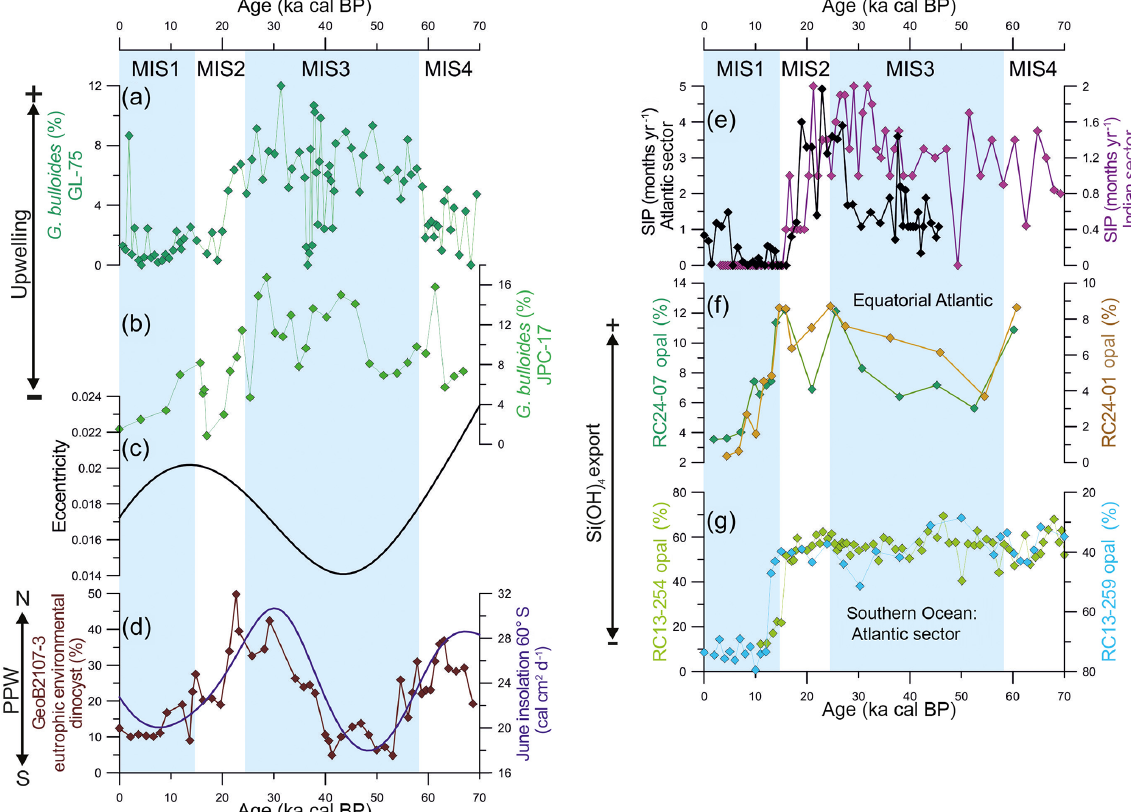
Figure 4. The mechanism behind the changes in productivity in the southern Brazilian margin over the last 70kyr. Abundance of upwelling indicator species Globigerina bulloides from (a) core GL-75 (21 ◦ S; Portilho-Ramos et al., 2015) and (b) core JPC-17 (27 ◦ S; this study). (c) Eccentricity of the Earth’s orbit (Berger and Loutre, 1991). (d) The abundance of dinoflagellate cysts from core GeoB2107-3 (27 ◦ S) representing the influence of the Plata Plume Water in the southern Brazilian margin (Gu et al., 2017) and austral winter (June) insolation at 60 ◦ S (Berger and Loutre, 1991). (e) Antarctic sea ice presence (SIP) in the Atlantic sector core TN057-13-PC4 (53 ◦ 20 (cid:48) S, 5 ◦ 10 (cid:48) W; Shemesh et al., 2002) and Indian sector core SO136-111 (56 ◦ 40 (cid:48) S, 160 ◦ 14 (cid:48) W; Crosta et al., 2004) of the Southern Ocean derived from diatoms assemblage. (f) Opal content in the equatorial Atlantic upwelling off northwestern Africa from core RC14-01 (0.55 ◦ N, 13 ◦ 65 (cid:48) W) and core RC24-07 (1 ◦ 33 (cid:48) S, 11 ◦ 92 (cid:48) W) (Bradtmiller et al., 2007) as well as (g) in the Atlantic sector of the Southern Ocean from core RC13-254 (48 ◦ 34 (cid:48) S, 5 ◦ 34 (cid:48) E) and core RC13-259 (53 ◦ 53 (cid:48) S, 4 ◦ 56 (cid:48) W) (Mortlock et al., 1991) as proxies for silicic acid transport toward low latitudes. Core RC13-254 is located to the north of the Antarctic Polar Zone (APZ), whereas core RC13-254 is located to the south of the APZ. Note the inverted (RC13-259) axis in (f)